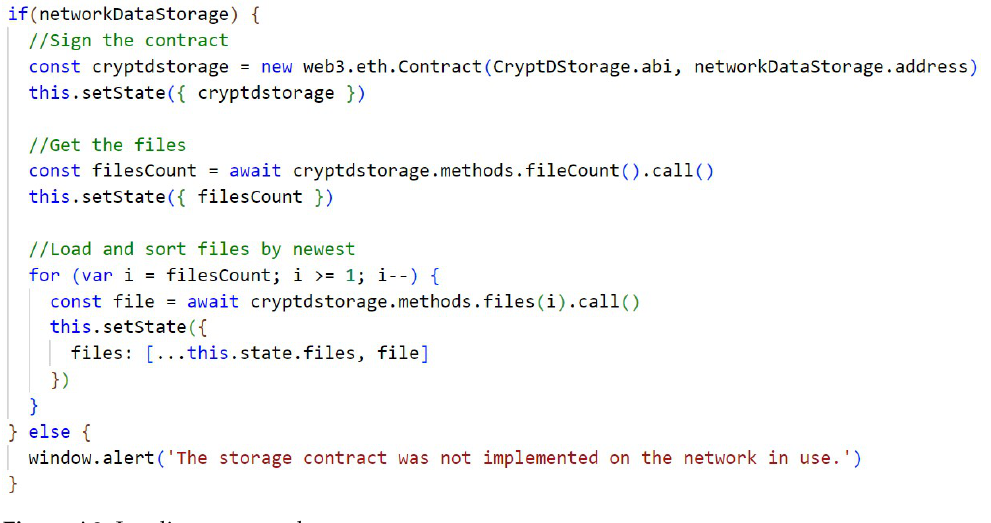
Figure A3. Loading contract data.